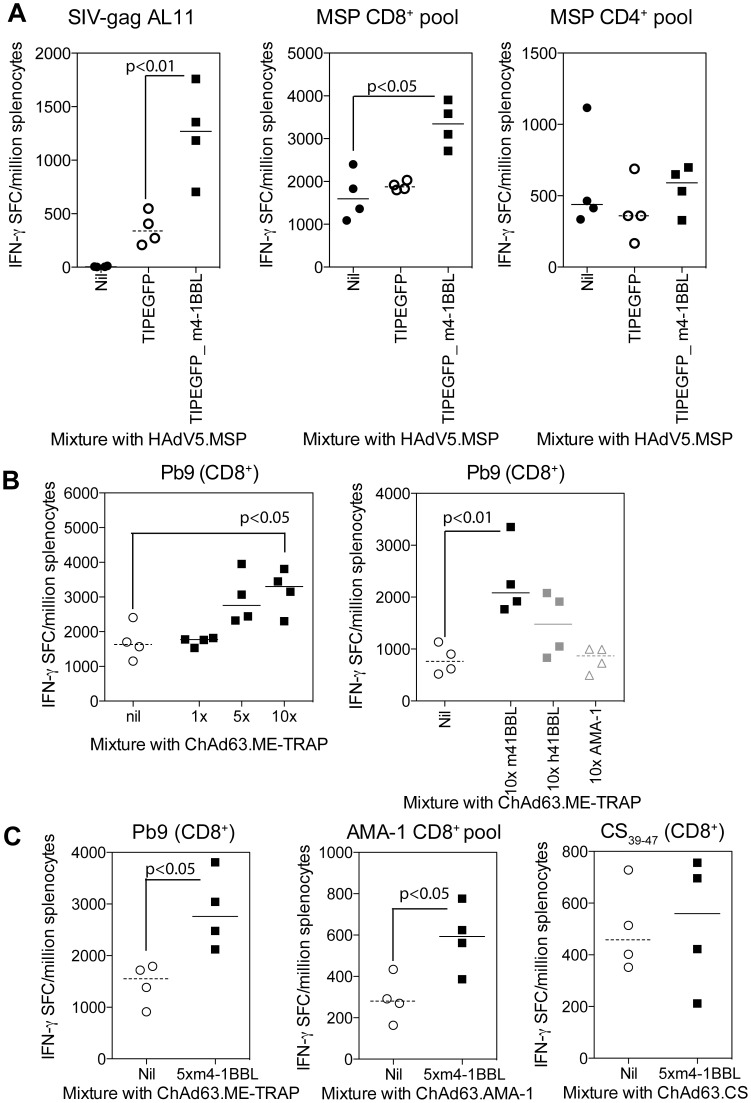
Coadministration of vectors expressing 4-1BBL.
A) C57BL/6J mice were vaccinated i.m. with 2.8×106 iu of HAdV5.MSP either alone or mixed with 107iu of HAdV5.TIP-EGFP or HAdV5.TIP-EGFP 4-1BBL. Spleens were harvested 2 weeks later and the response to TIP antigen SIV, a pool of CD8+ T cell epitopes from MSP or a pool of CD4+ T cell epitopes from MSP measured by IFN-γ ELISpot. B) In separate experiments, Balb/c mice were vaccinated i.m. with 106 iu of ChAd63.ME-TRAP mixed together with different ratios of ChAd63-m4-1BBL (left) or with 107iu of ChAd63.m4-1BBL, ChAd63.h4-1BBL or ChAd63.AMA-1 (right). Spleens were harvested 2 weeks later and the response to Pb9 measured by IFN-γ ELISpot. C) Balb/c mice were immunised i.m. with 106iu ChAd63.ME-TRAP, ChAd63.AMA-1 or ChAd63.CS with or without 107iu ChAd63.m4-1BBL. Spleens were harvested 2 weeks later and antigen specific IFN-γ responses to the relevant antigens measured by ELISpot. For all experiments bars represent the median per group with each individual animal displayed as a single point. Each experiment was analysed with a one-way analysis of variance a post-hoc Bonferroni test (A&B) or an unpaired t-test (C); the p values denote the level of statistical significance.